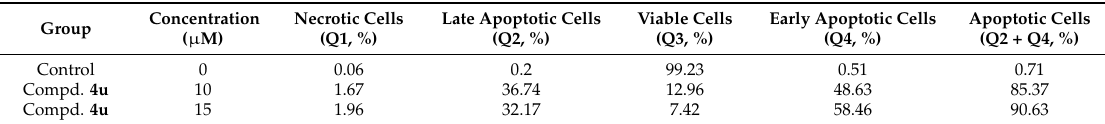
Table 2. Quantitative apoptosis assay of HeLa using Annexin V-FITC (Fluorescein Isothiocyanate)/PI (Propidium Iodide) dual staining method.